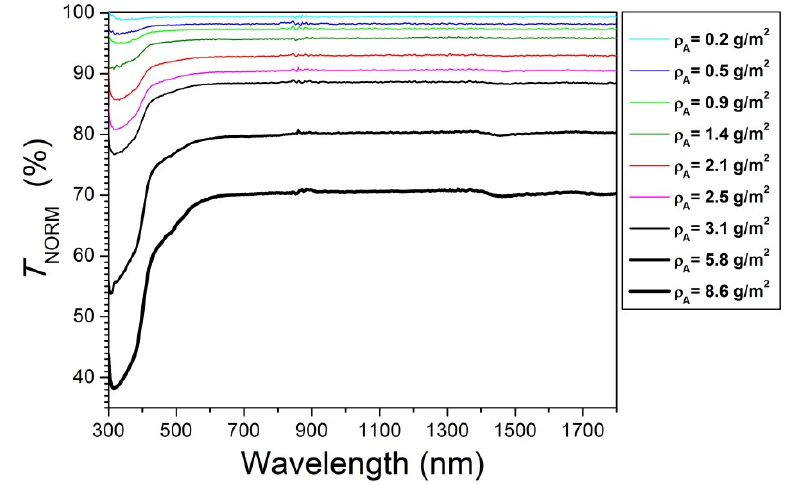
Figure 10. Normalized transmittance ( T NORM ) spectra as a function of the pollen mass density ( ρ A ). Within the visible (VIS) range, cypress pollen exhibited non-selective light scattering. That